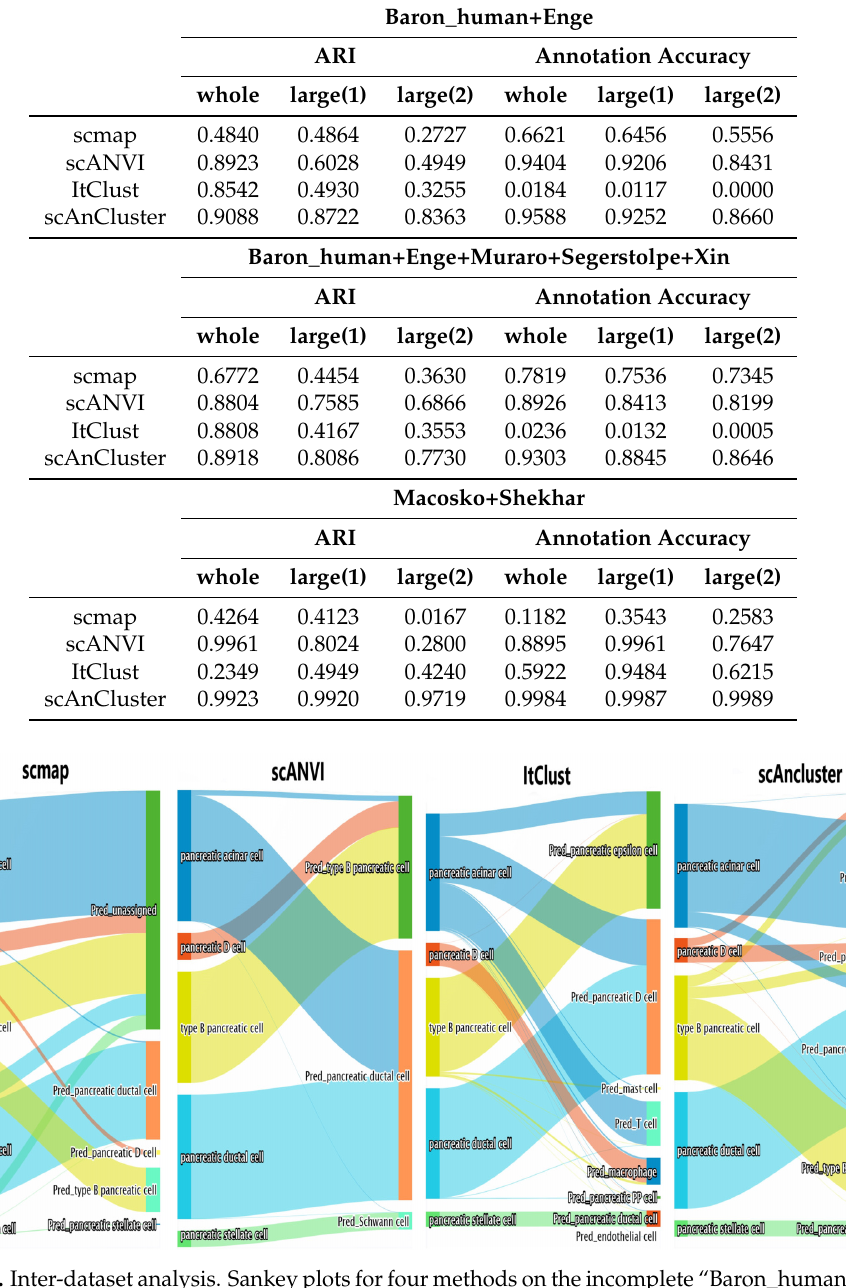
Figure 4. Inter-dataset analysis. Sankey plots for four methods on the incomplete “Baron_human+Enge” dataset that removes the pancreatic acinar cells in the “Baron_human”